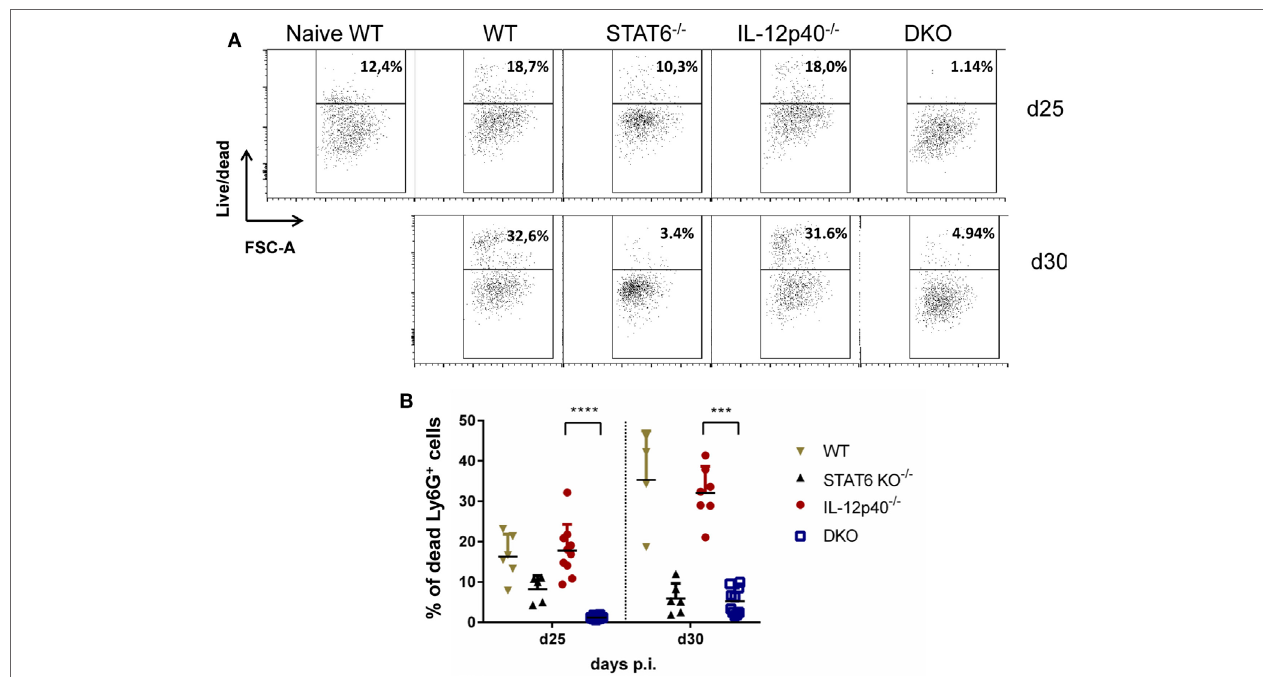
FigUre 6 | Neutrophils in IL-12p40 − / − STAT6 − / − double knockout (DKO) mice are less apoptotic. Wild type, IL-12p40 − / − , STAT6 − / − , and DKO BALB/c mice were infected with 2 × 10 6 metacyclic promastigotes. Footpads of naïve and infected mice at d25 and d30 post-infection were homogenized and analyzed by flow cytometry as explained in Figure S2 in Supplementary Material after a live/dead staining. Ly6G + neutrophils were plotted on (a) live/dead versus FSC-A axes and their (B) percentages of living Ly6G + neutrophil population expressed. Data represent two independent experiments with at least four footpads per group. 1,000 cells per FACS plot are displayed for each group. Error bars are shown as SDs. *** p < 0.001, **** p <